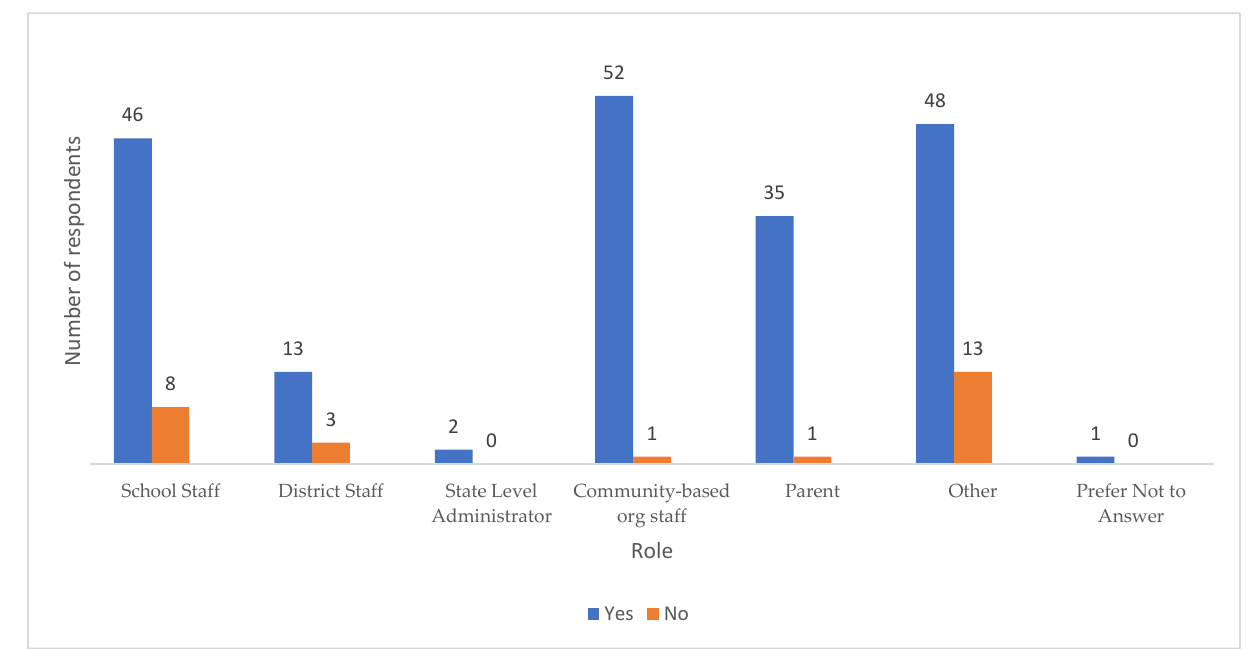
Figure 1. Respondents reporting learning new family engagement tools.